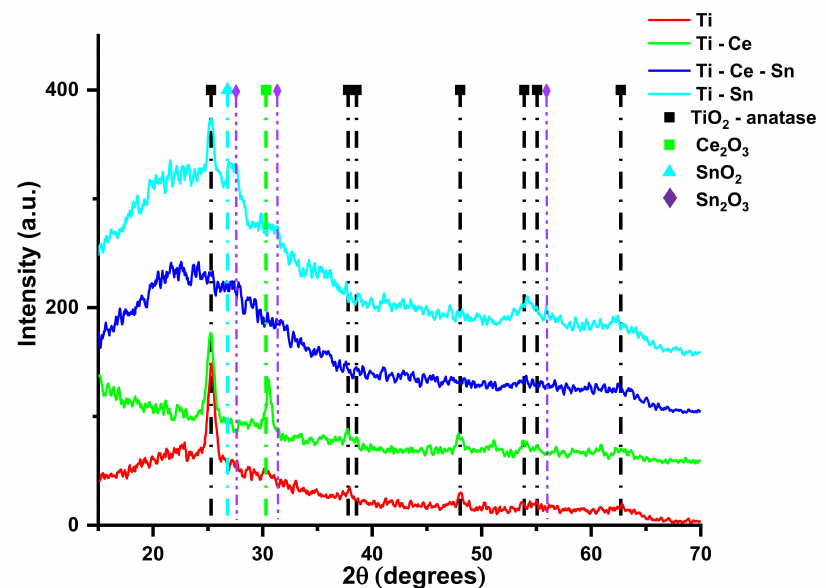
Figure 2. XRD patterns of TiO 2 -Me x O y films.